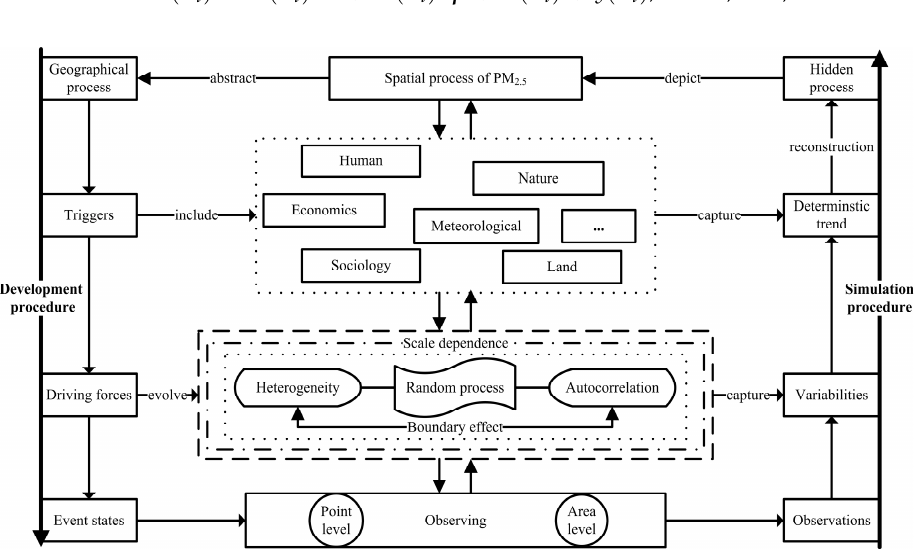
Figure 1. Modelling framework of PM 2.5 spatial process.